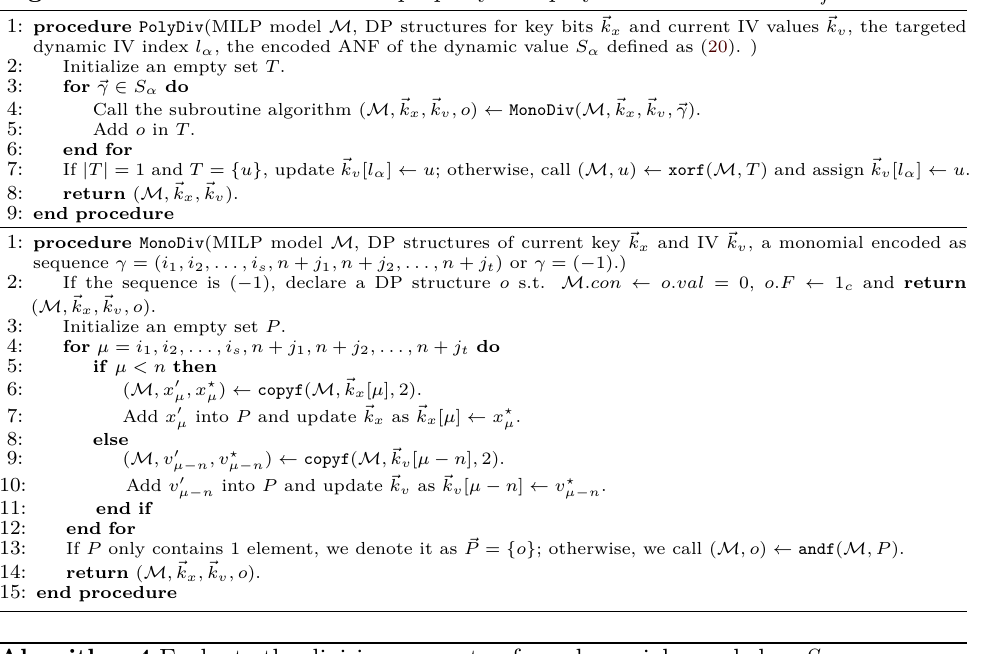
Algorithm 3 Evaluate the division property of a polynomial encoded as S f .